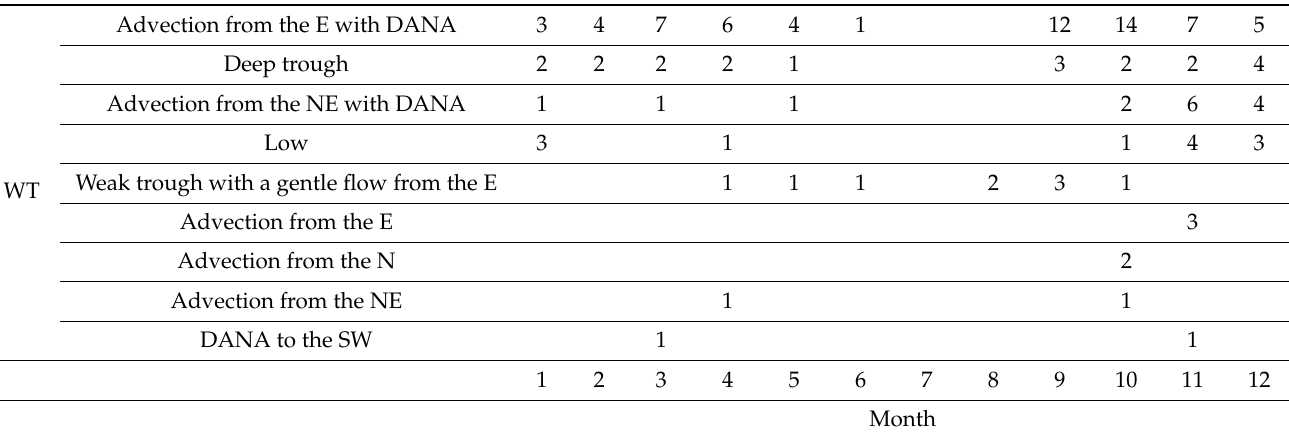
Table 5. Monthly absolute frequencies according to the classification by Mart í n Vide [20].